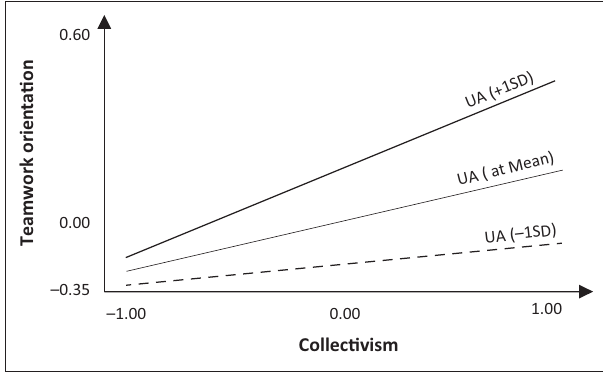
FIGURE 3: Simple slope: Uncertainty avoidance as a moderator between the effect of collectivism on individual team orientation.